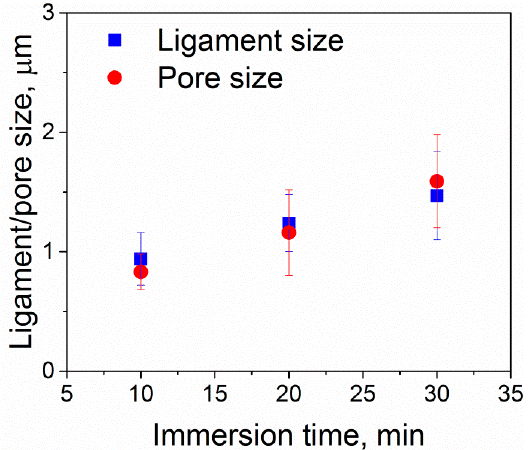
Figure 6. Surface characteristics of Ti-6Al-7Nb after dealloying in liquid Mg at 1150 K. Ligament/pore size platted against dealloying time. Note: The ligament/pore size was characterized by ImageJ software using the electron micrographs like those shown in Figure 4; the error bars indicate standard deviation.